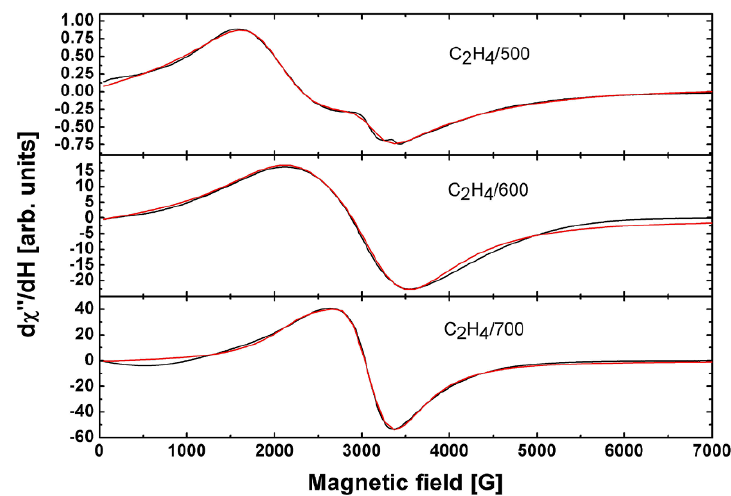
Figure 2. Experimental (black) and fitted (red) spectra of three samples carburized in ethylene. Table 1. Magnetic resonance parameters of the component